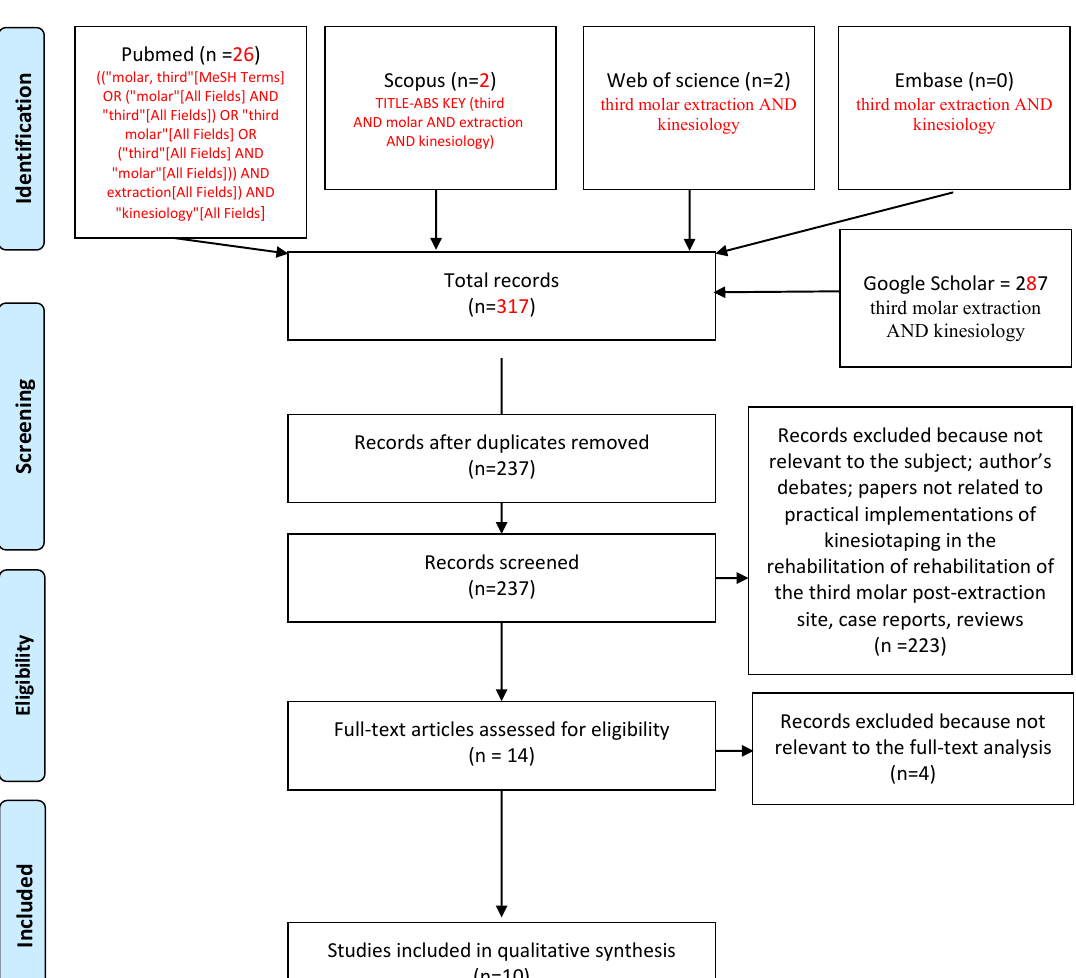
Figure 1. Prisma 2009 flow diagram representing the study selection process.